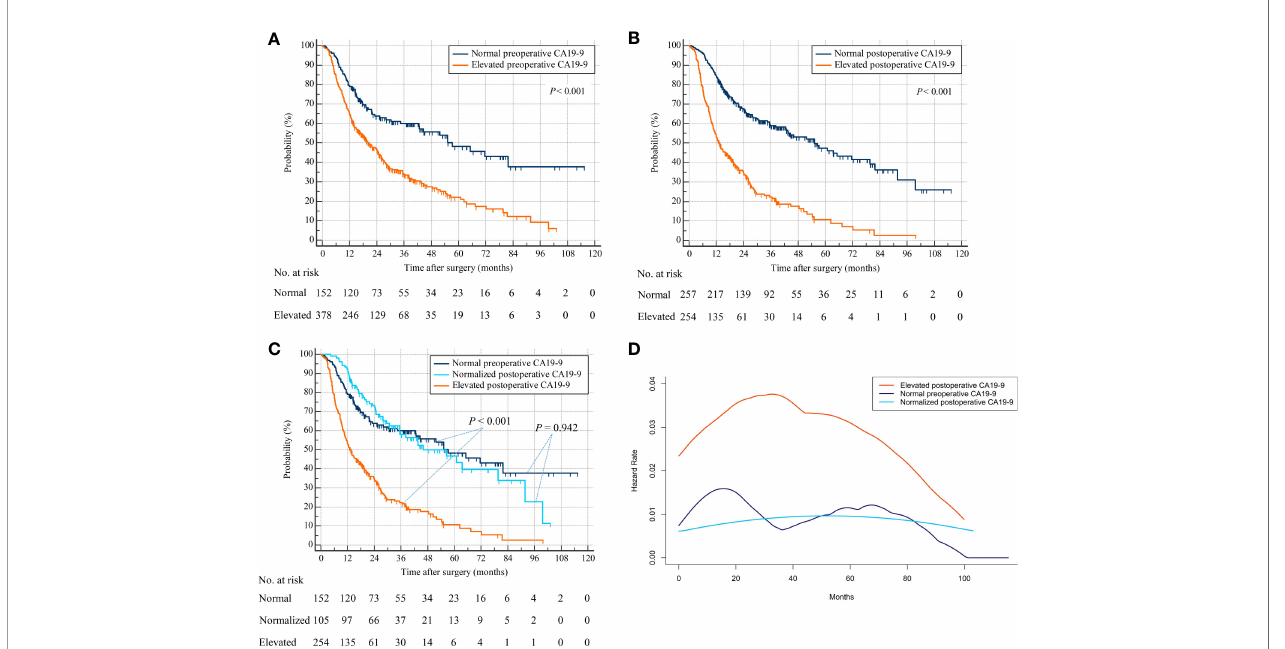
FIGURE 3 | Overall survival by preoperative and postoperative CA19-9 levels. (A) Patients with normal versus elevated preoperative CA19-9. (B) Patients with normal versus elevated postoperative CA19-9. (C) Patients with normal preoperative versus normalized or persistently elevated postoperative CA19-9. (D) Hazard functions for death in the three patient